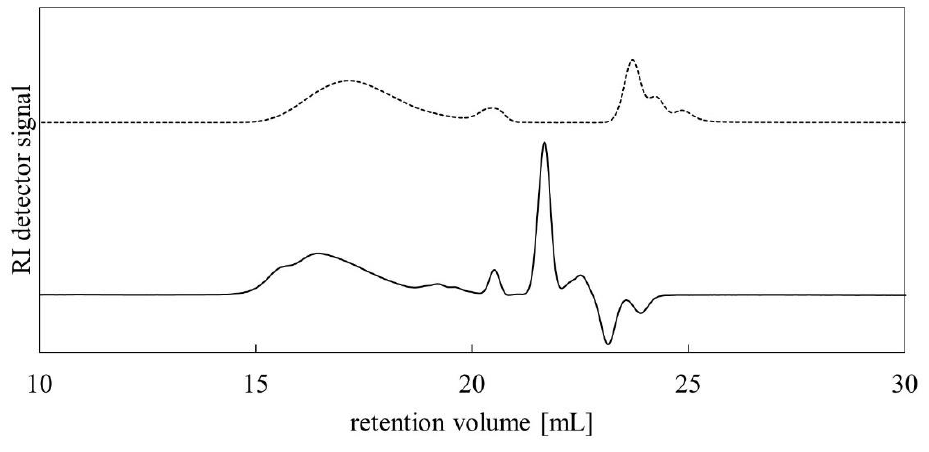
Figure 7. GPC chromatograms of initial PMHS (dotted line) and synthesized PMFOS (solid line).